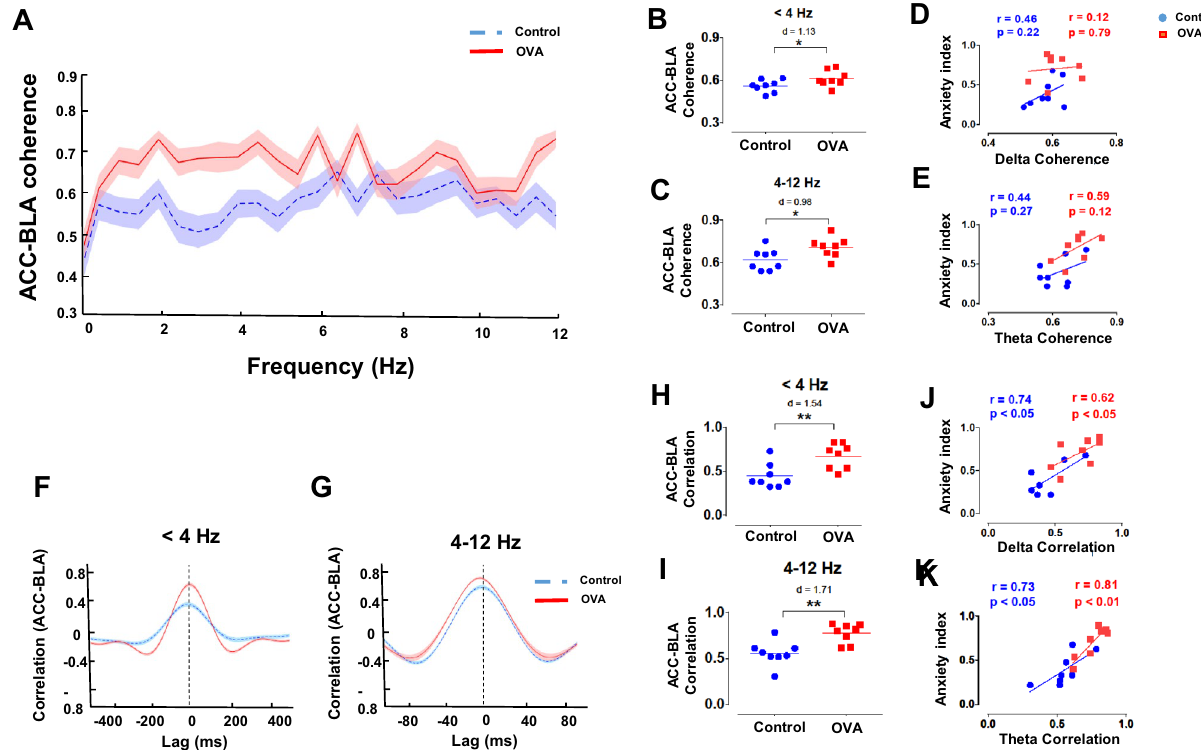
Figure 5. ACC-BLA functional connectivity. ( A, F, G ) Coherence spectra ( A ) and cross-correlation ( F, G ) between ACC and BLA. Shaded regions demonstrate SEM. ( B, C, H, I ) Values of coherence ( B, C ) and correlation ( H, I ) between ACC and BLA at delta (upper panels) and theta (lower panels) frequency bands. The horizontal bars indicate mean values. ( D, E, J, K ) Correlation between levels of anxiety and ACC-BLA coherence ( D, E ) and cross-correlation ( J, K ) at delta (upper panels) and theta (lower panels) frequency bands. Correlation coefficient (r) was performed using Pearson correlation coefficient analysis. Data were analyzed by t-test, n = 8 per group. *p < 0.05, **p < 0.01 compared to control. OVA, ovalbumin; ACC, anterior cingulate cortex; BLA, the basolateral